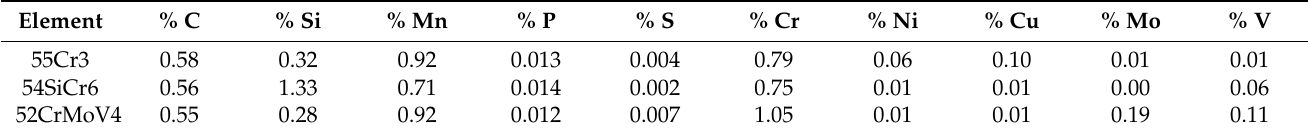
Table 2. Chemical composition of the steels in